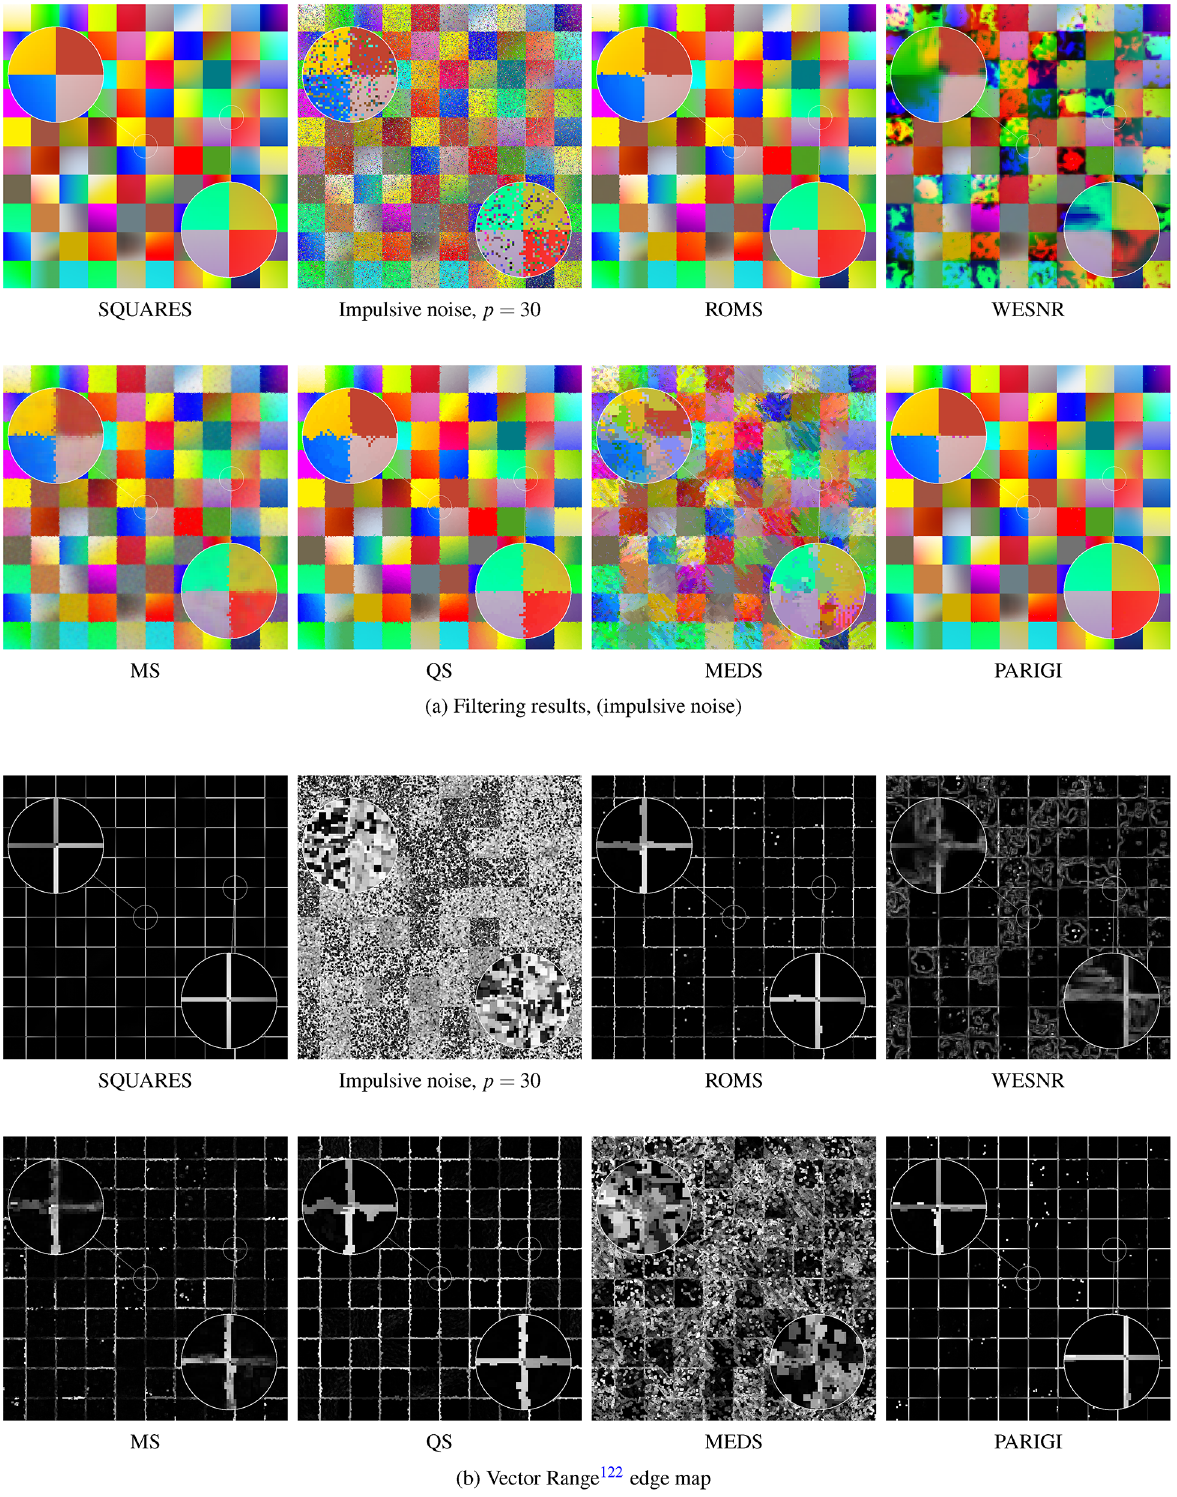
Figure 9. Efficiency comparison of the the proposed ROMS with MS and its fast modifications using the SQUARES test image contaminated with impulsive noise p = 30%